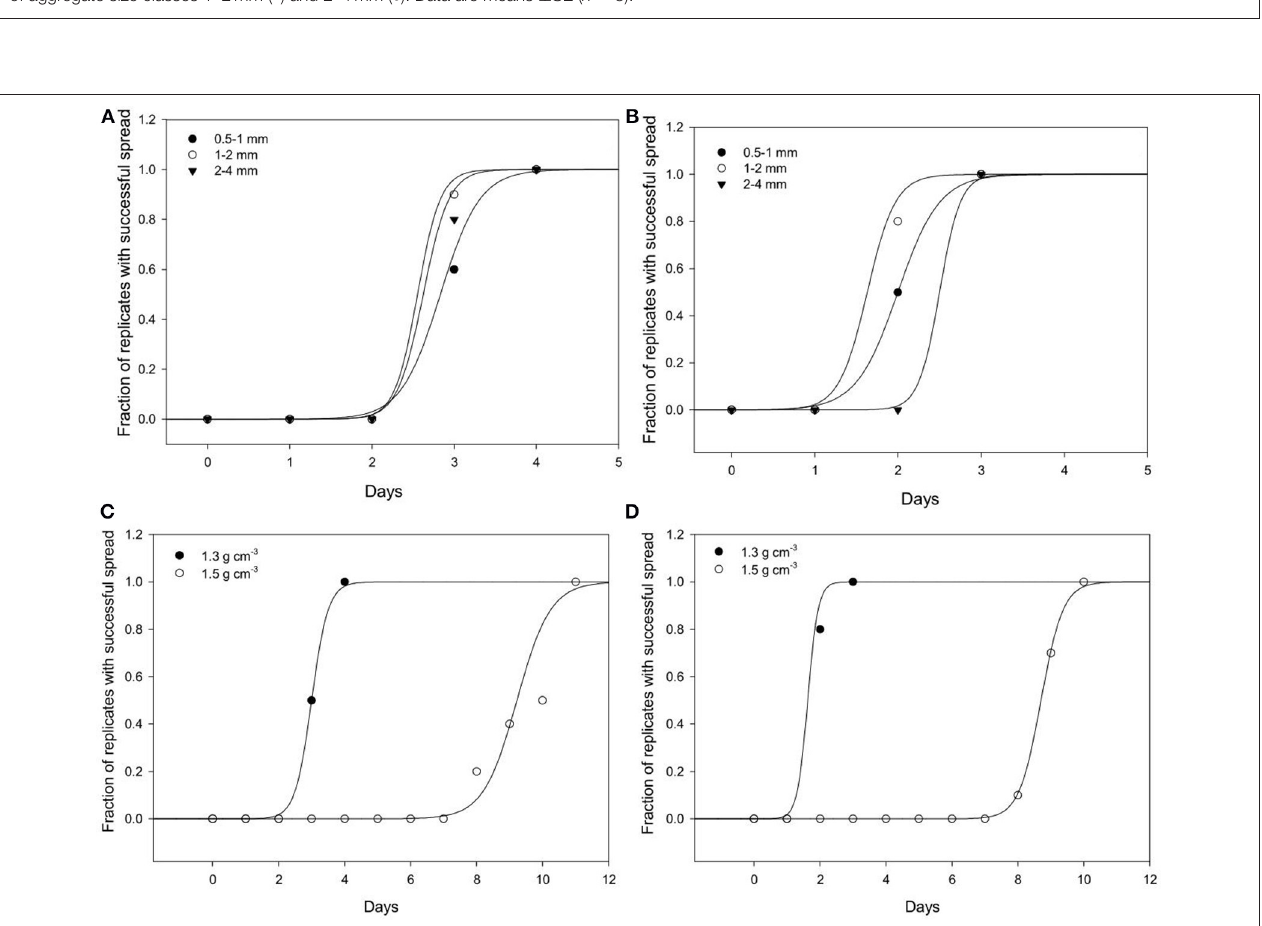
FIGURE 7 | Dynamics of spread of Pseudomonas sp. and Bacillus sp. through soil. The number of replicates in which Pseudomonas (A) and Bacillus (B) successfully spread through soil of aggregates 0.5–1 ( • ); 1–2 ( ◦ ); 2–4 ( N ) mm packed at a bulk-density of 1.3g cm − 3 . The effect of soils packed at a BD of 1.3 or 1.5g cm − 3 (AS 1–2mm and wetness 60%) on the spread of Pseudomonas (C) and Bacillus (D) . For all treatments successful colonization was quantified as the number of successful colonizations of target bait placed at specified distances from a source of inoculum.